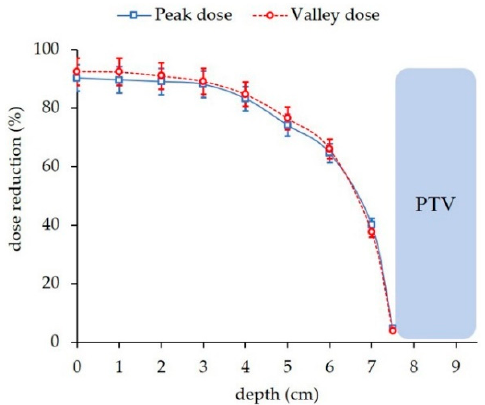
Figure 5. Dose reduction to normal tissue along the beam axis at peak and valley positions in the pMBAT scenario with respect to the standard pMBRT case. The profile considered to evaluate the dose reduction is represented by a white dotted line in Figure 4c.